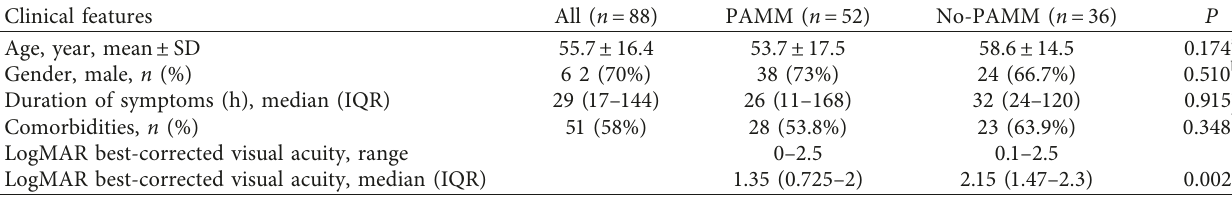
Table 2: Demographic and clinical characteristics of patients with retinal artery occlusion.